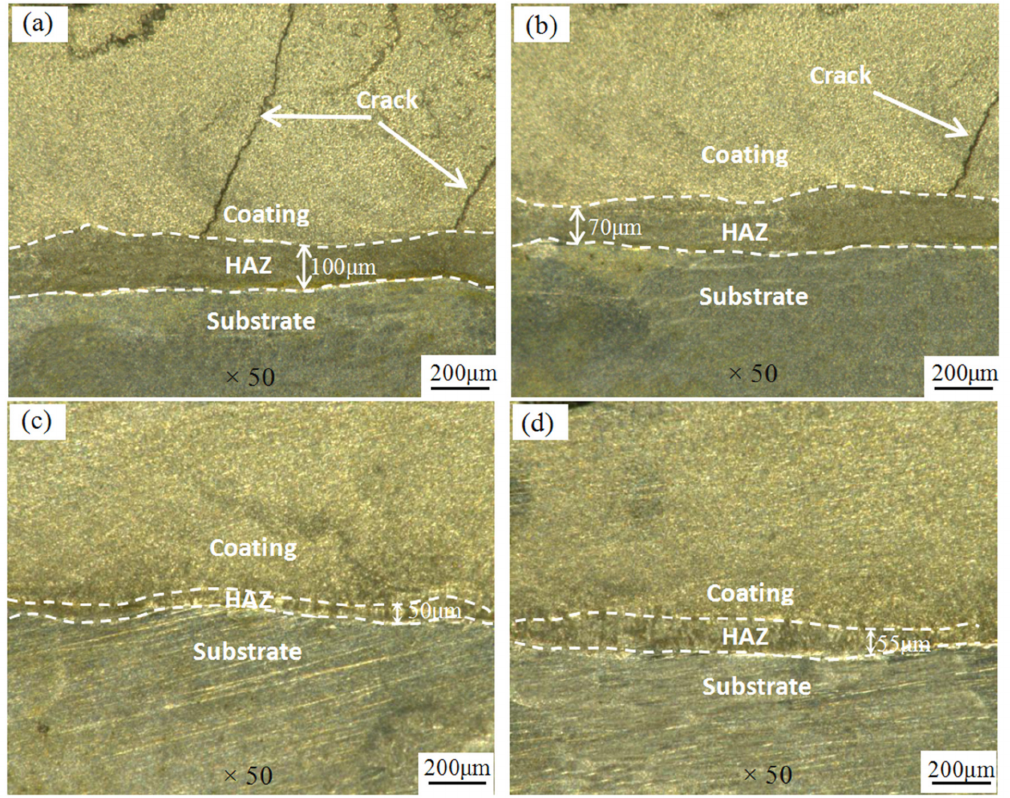
Figure 3. The cross-sectional optical micrographs of coatings, ( a ) Coating I; ( b ) Coating II; ( c ) Coating III; ( d ) Coating IV.